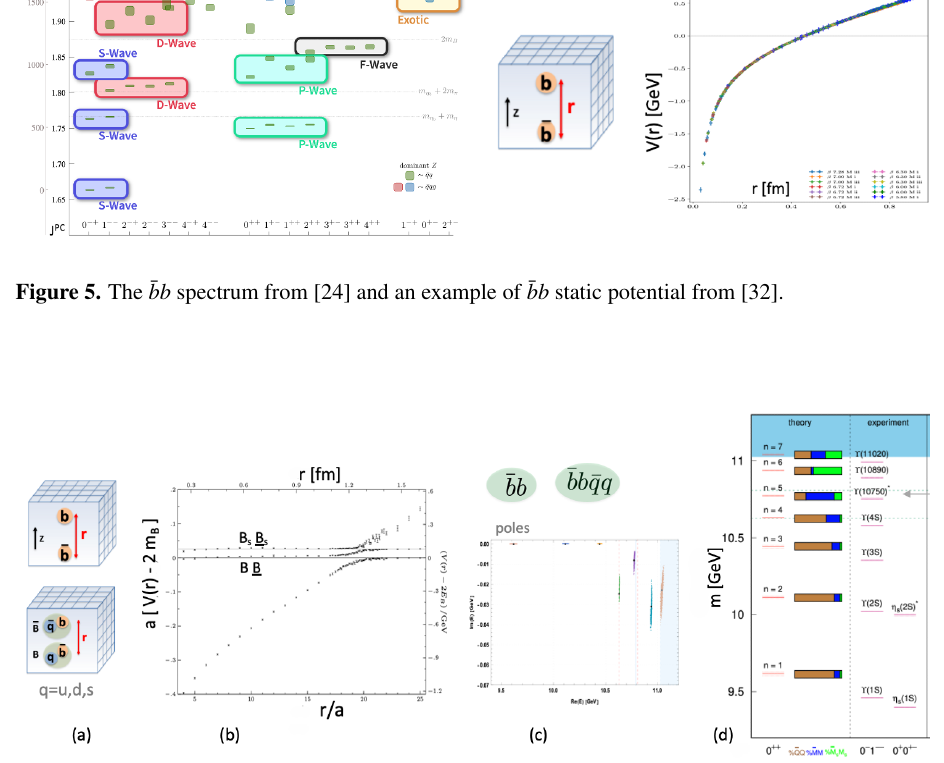
Figure 6. (a,b) The static potential of the quarkonium system that accounts also for the coupling to a pair of heavy mesons [25]. (c,d) Poles and composition of the bottomonium-like states [27] from analogous static potential